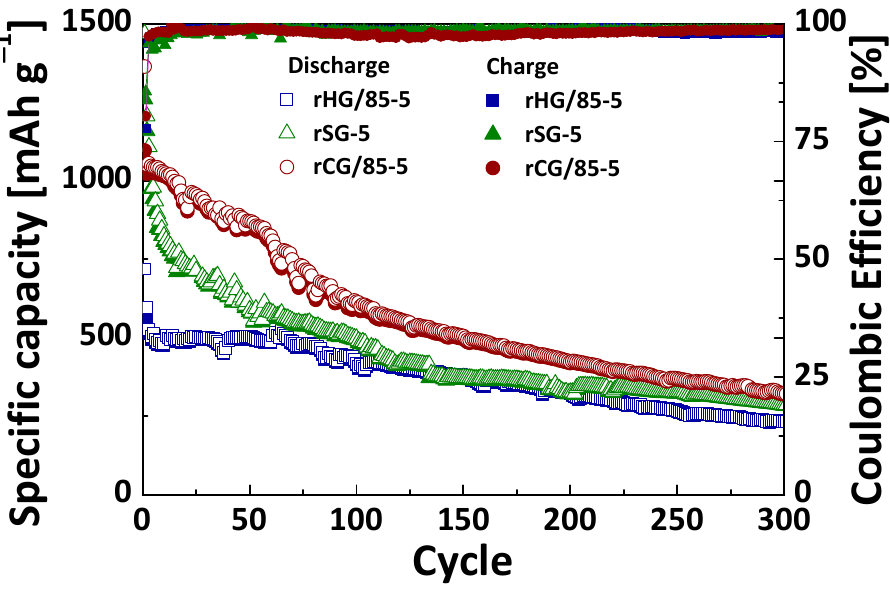
Figure 9. Galvanostatic cycling at 500 mA g − 1 of silica, C-Si hybrid and C/Si composite reduced with a heating rate of 5 °C min − 1 .